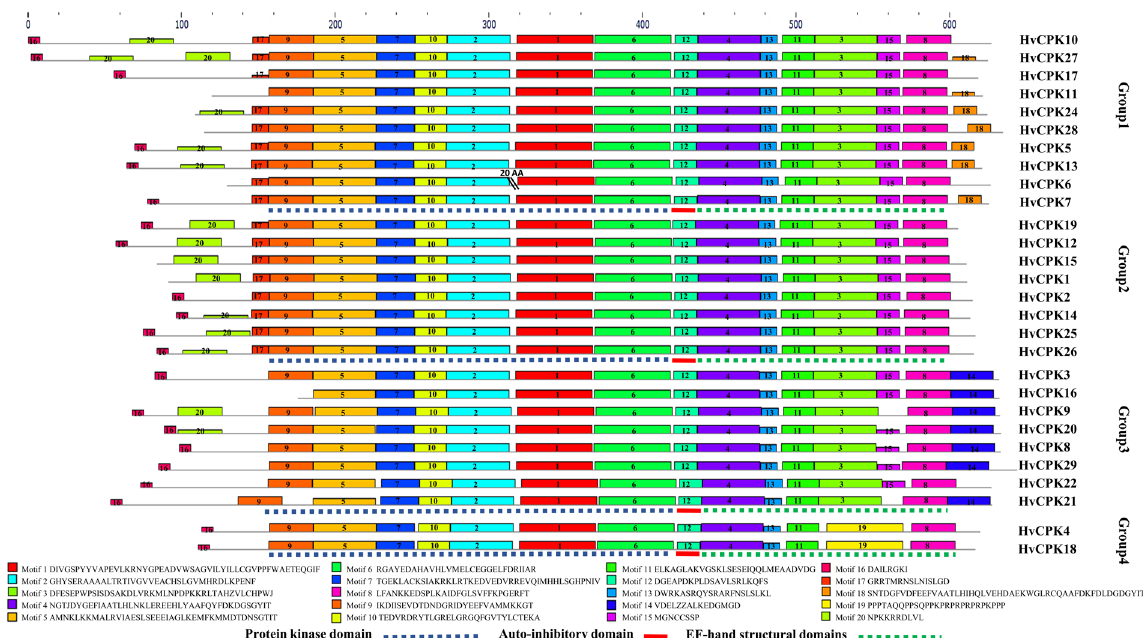
Figure 2. Motif organizations in 28 Hv CDPK s. The conserved motifs were detected using the MEME online tool (http://meme.sdsc.edu/meme/intro.html) and SMART (http://smart.embl-heidelberg.de/). The conserved protein kinase domain, auto-inhibitory domain and EF-hand structural domain are denoted by blue, red and green underlined, respectively.